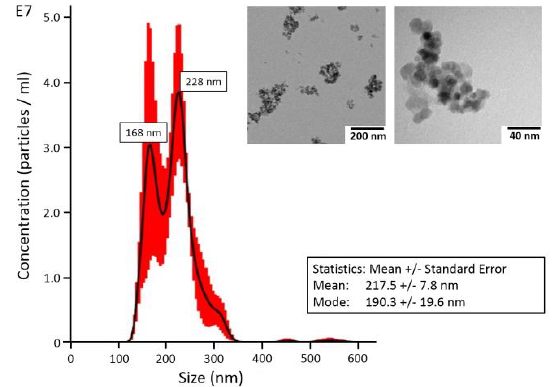
Figure 1. Size distribution of Fe-Si nanoparticles (Fe-Si-NP) in aqueous suspension as used for intratracheal instillation. Measurements were carried out by NanoSight optical tracking analysis. The inset shows electron microscopic images of Fe-Si-NP as typically found in the instilled suspension.